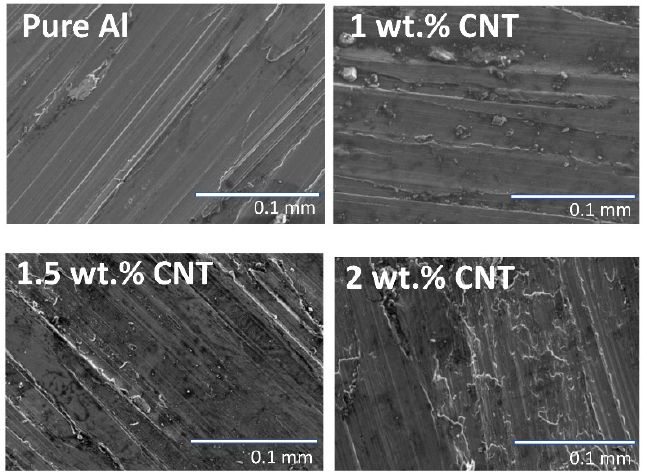
Figure 8. SEM images of the worn surface of pure aluminum alloy and CNT-reinforced aluminum alloy and wear rate data under a load of 2 kg at 500 rpm [134].